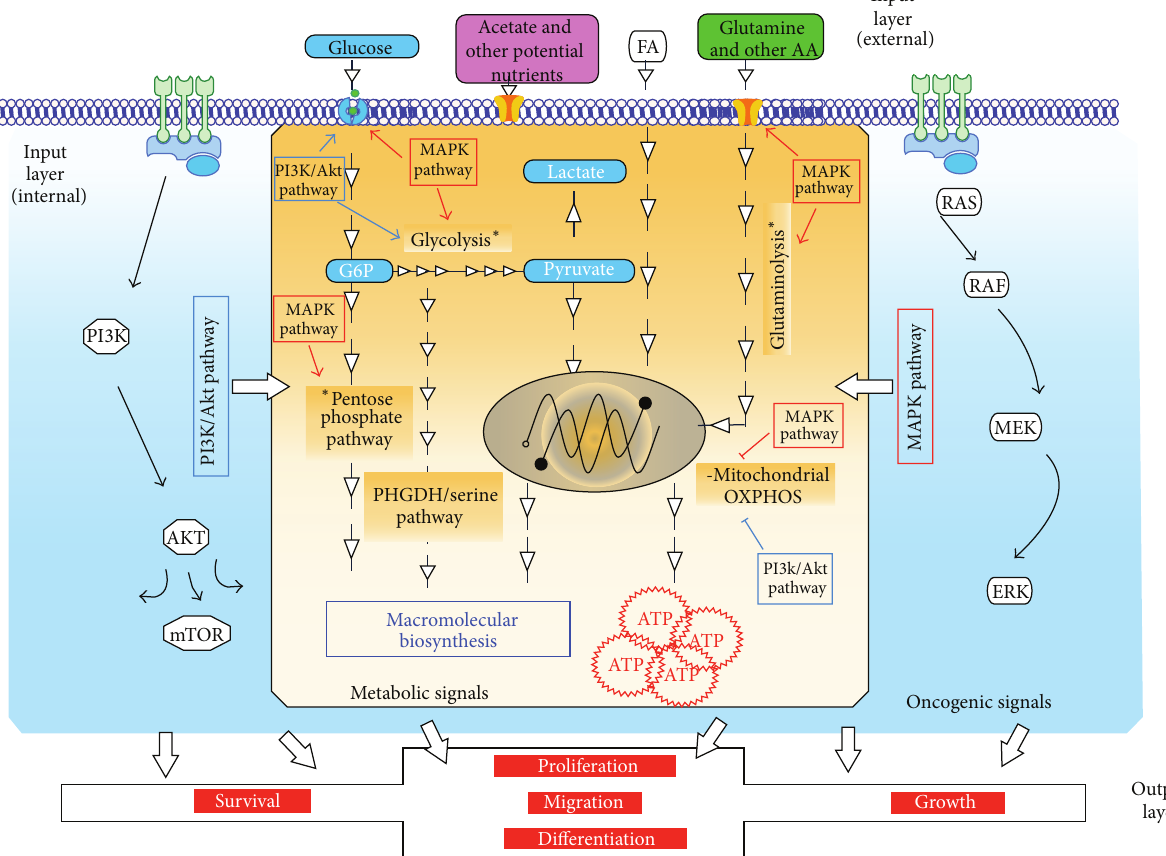
Figure 1: General organization of the metabolic networks in cancer cells. The input layer’s internal (oncogenic signals) and external (nutrients in the environment) signals influence the organization of metabolic pathways and thereby regulate the output layer (see text for details). The general impact of the main oncogenic signals (PI3K/Akt and MAPK pathways) on the metabolic organization of cancer cells is